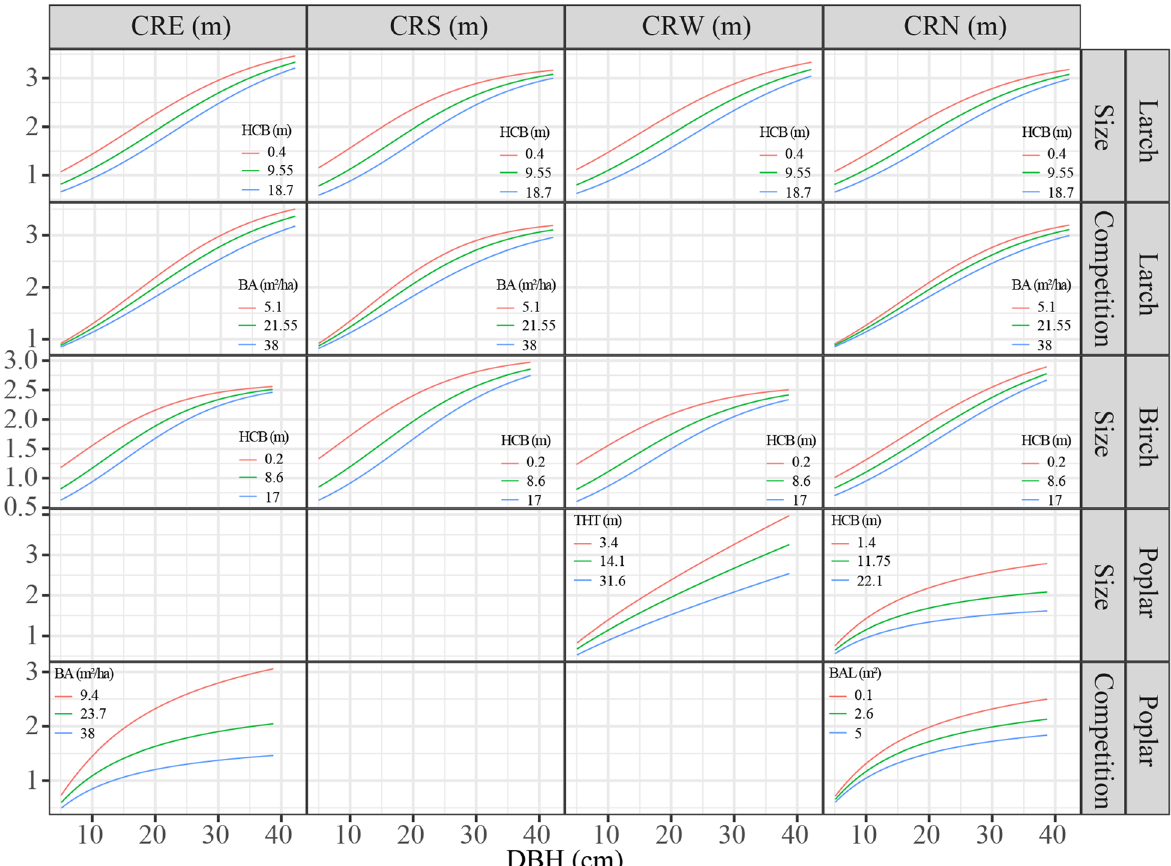
Fig. 4 Contribution of different covariates including tree size (HCB and THT) and competition (BA and BAL) to CR for larch, birch, and poplar. The curves were generated by using the average values of the covariates in Table 2, the parameters of NSURMEM systems in Table 4, and the equal intervals of the test covariates from the minimum to the maximum